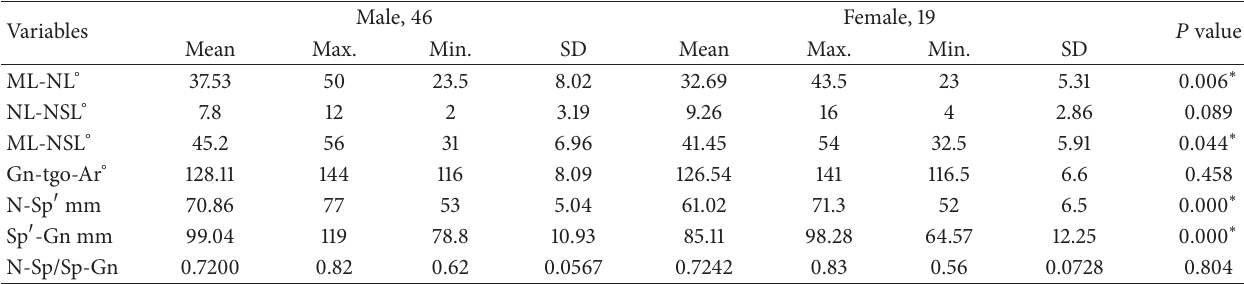
Table 3: The skeletal vertical variables for Yemeni adults with anterior open bite.